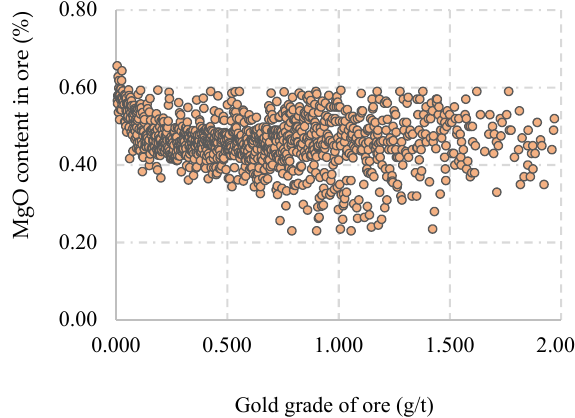
Figure 8. Scatterplot of K 2 O versus gold grade.